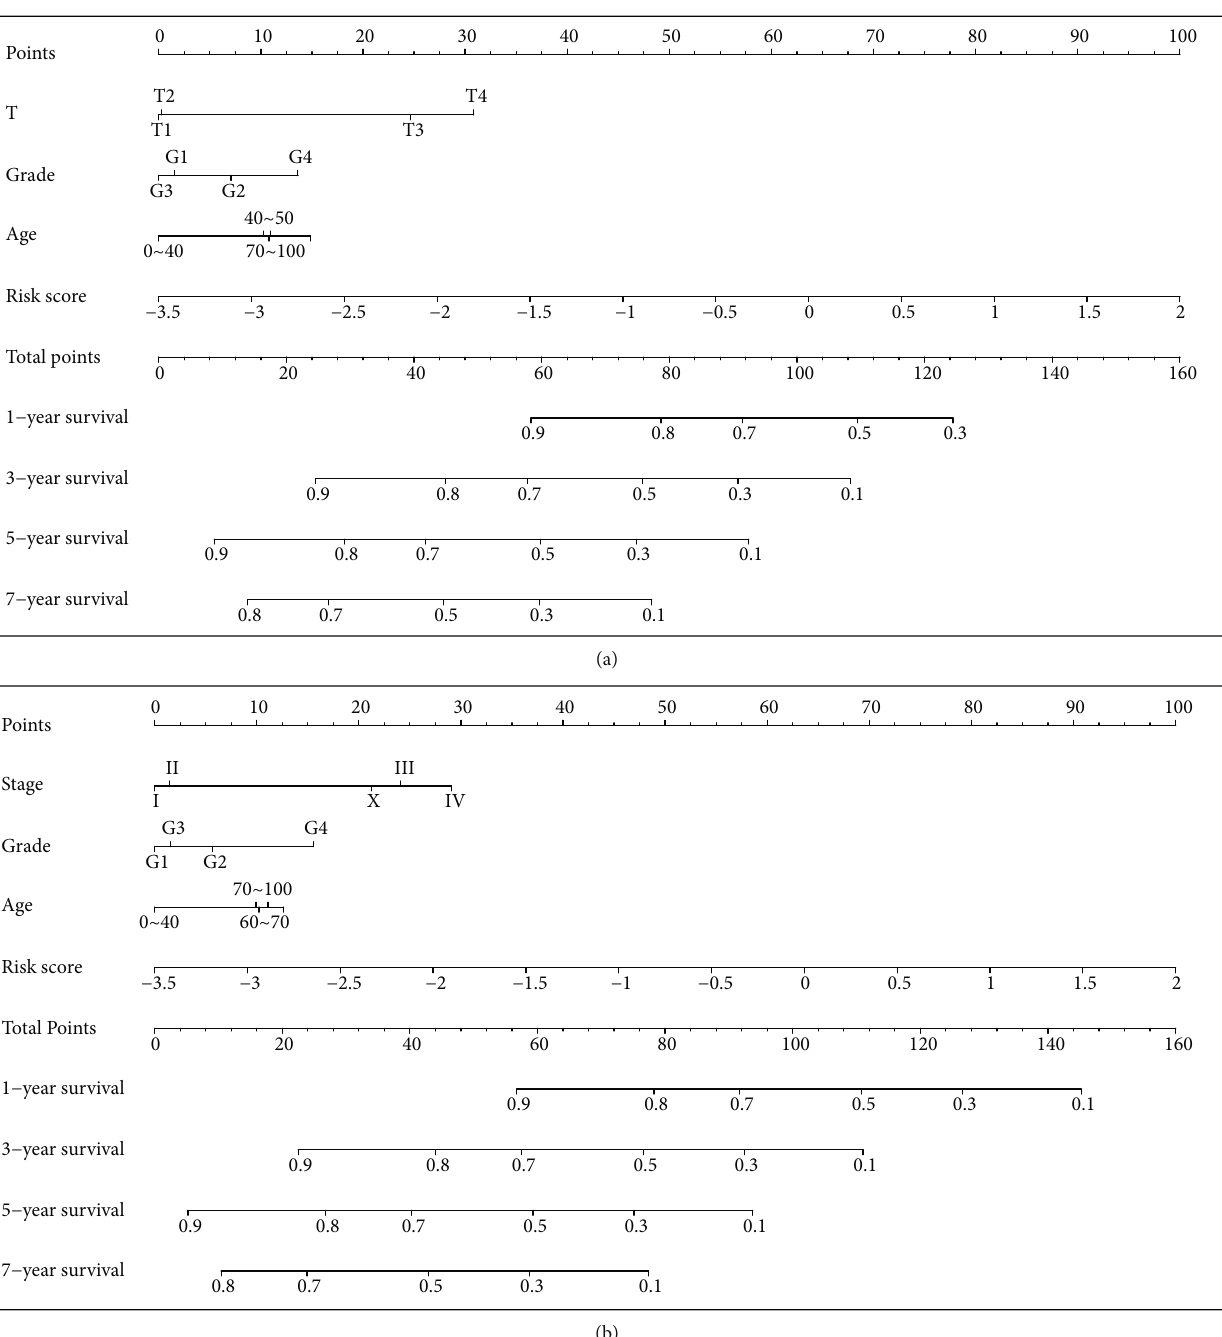
Figure 8: Prognostic value of nine IPGRs in HCC patients based on nomogram plots. (a) Clinical features (T, grade, and age) and risk score were analyzed to assess the survival time at 1, 3, 5, and 7 years for HCC patients. (b) Clinical features (stage, grade, and age) and risk score were analyzed to assess the survival time at 1, 3, 5, and 7 years for HCC